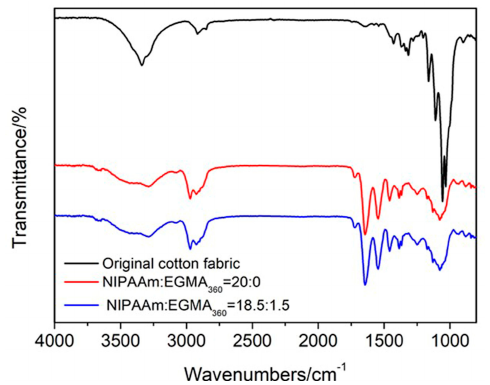
Figure 11. ( a ) ATR-FTIR spectra of original cotton fabric and cotton fabric grafted alginate- Ca 2+ /P(NIPAAm- co -EGMA 360 ) hydrogel from 4000 to 600 cm − 1 . The monomer ratio of NIPAAm